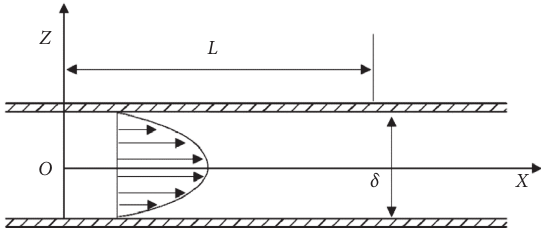
Figure 17: Flow field model of clearance